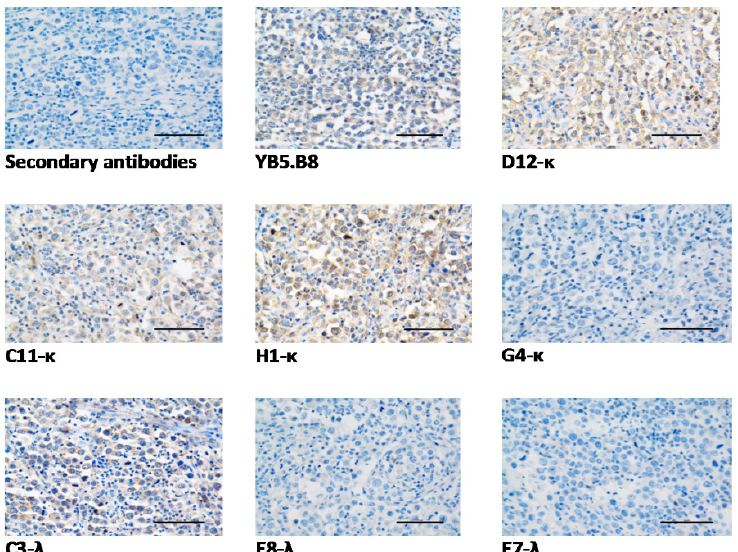
Figure 7. Immunohistochemistry staining of CD117 in high-grade canine CD117 mast cell tumor tissue sections using reformatted anti-canine CD117 mAbs. Bar = 50 µ m. Positive mAb binding was detected by diffuse cytoplasmic CD117 protein immunostaining of canine neoplastic mast